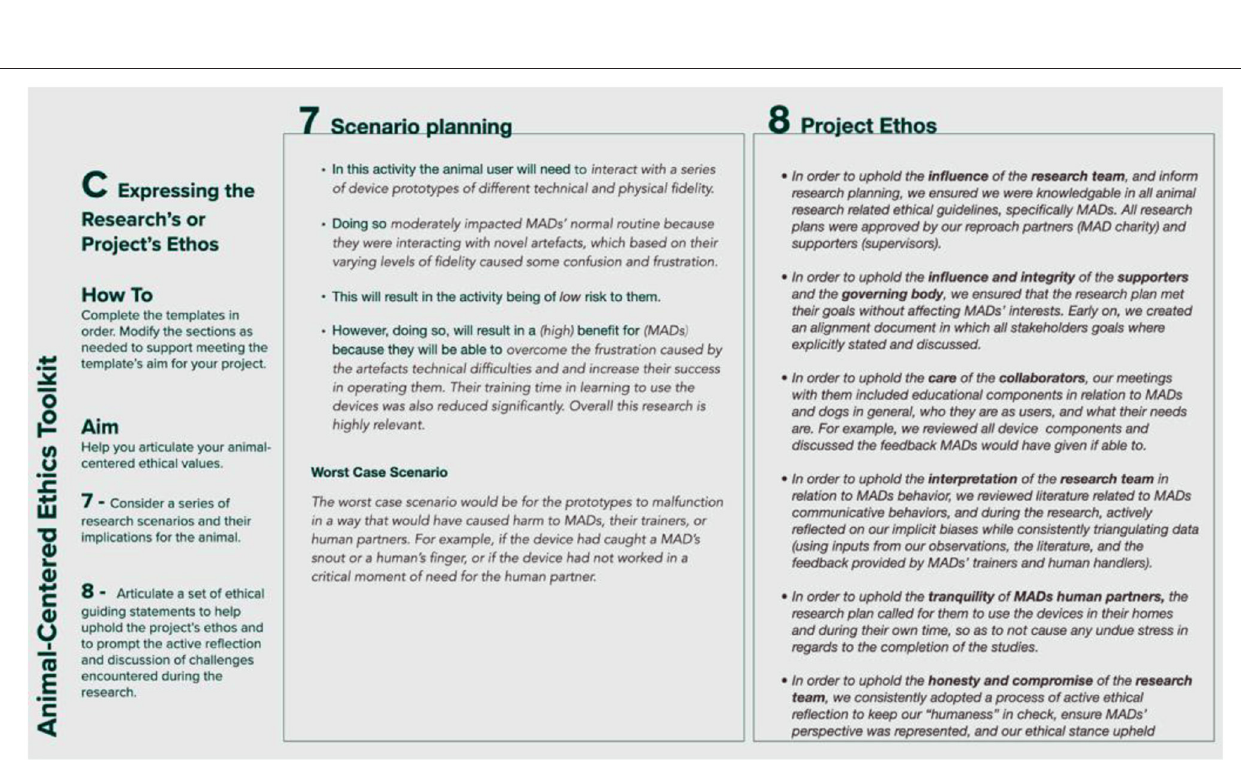
FIGURE 8 | Sample of template C: expressing the project’s ethos for the design of a set of canine-centric controls for Mobility Assistance Dogs.